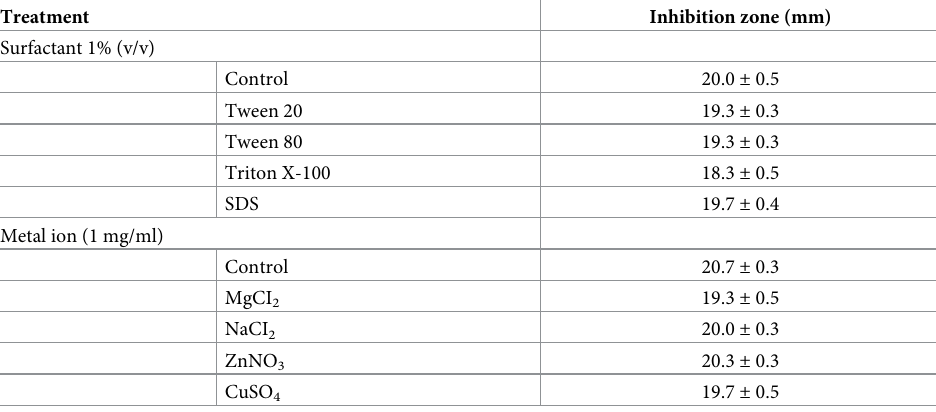
Table 2. Effect of surfactants and metal ions on inhibitory activities of strain PD9 CFS on MRSA ATCC 33742.